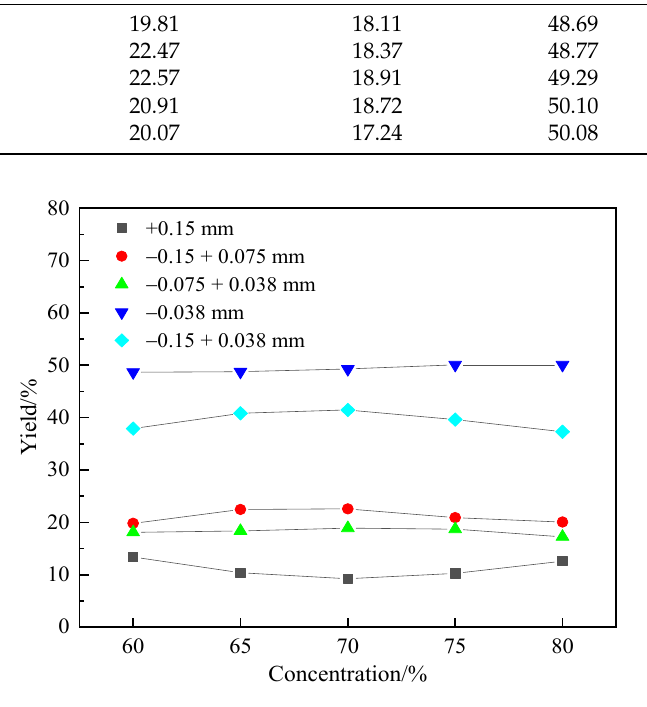
Figure 2. Particle size of grinding product at different grinding concentrations.